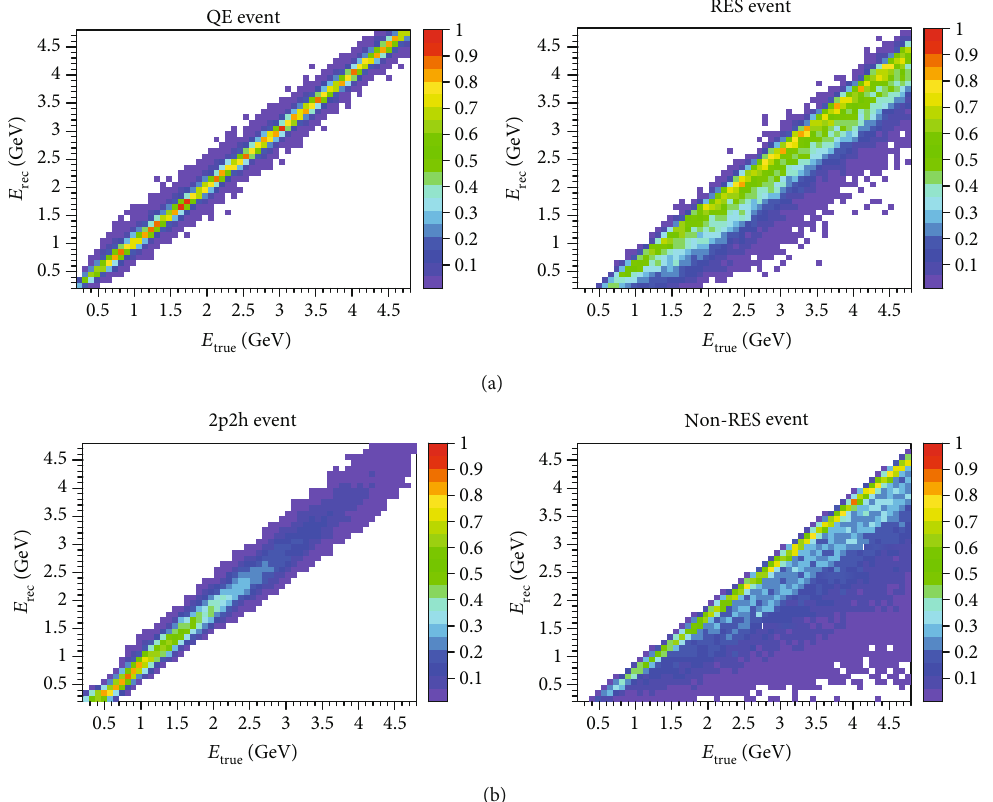
Figure 2: Two-dimensional migration matrices for QE , RES , 2p2h and non ‐ RES events (in (a) and (b) as indicated) generated using GiBUU for the argon target.